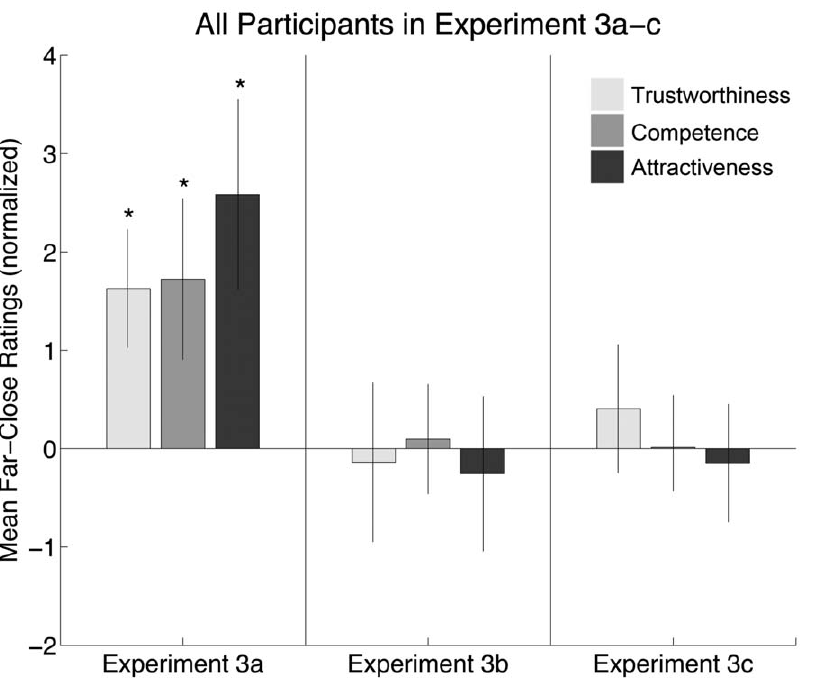
Figure 2. Social judgments as a function of perspective distortion (Experiment 3a), verbal information (Experiment 3b), and image size (Experiment 3c). In each Experiment, ratings were obtained for Trust (solid black bars), Competence (gray bars), and Attractiveness (white bars). The mean Far-Close score over all participants and stimulus faces is shown on the y-axis (with the error bar indicating the 95% confidence interval).